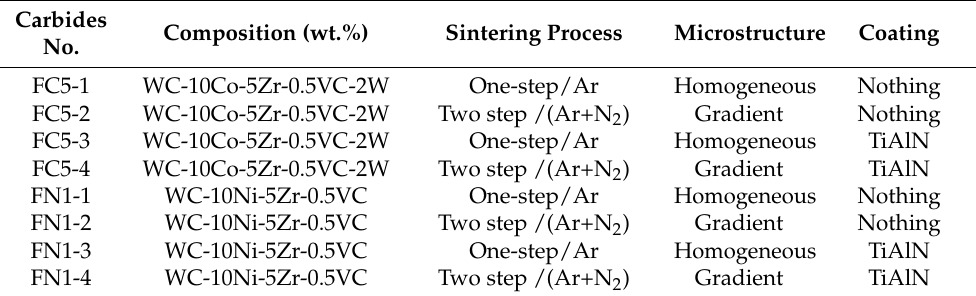
Table 1. The composition, microstructure, and coating type of WC-Co/Ni-Zr cemented